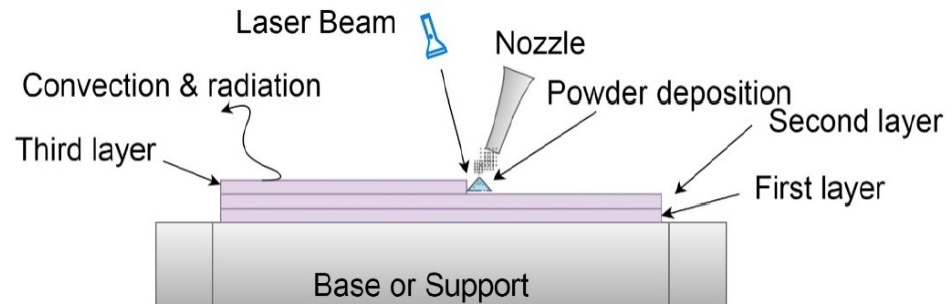
Figure 3. Schematic of boundary conditions of a multi-layered SLM process.